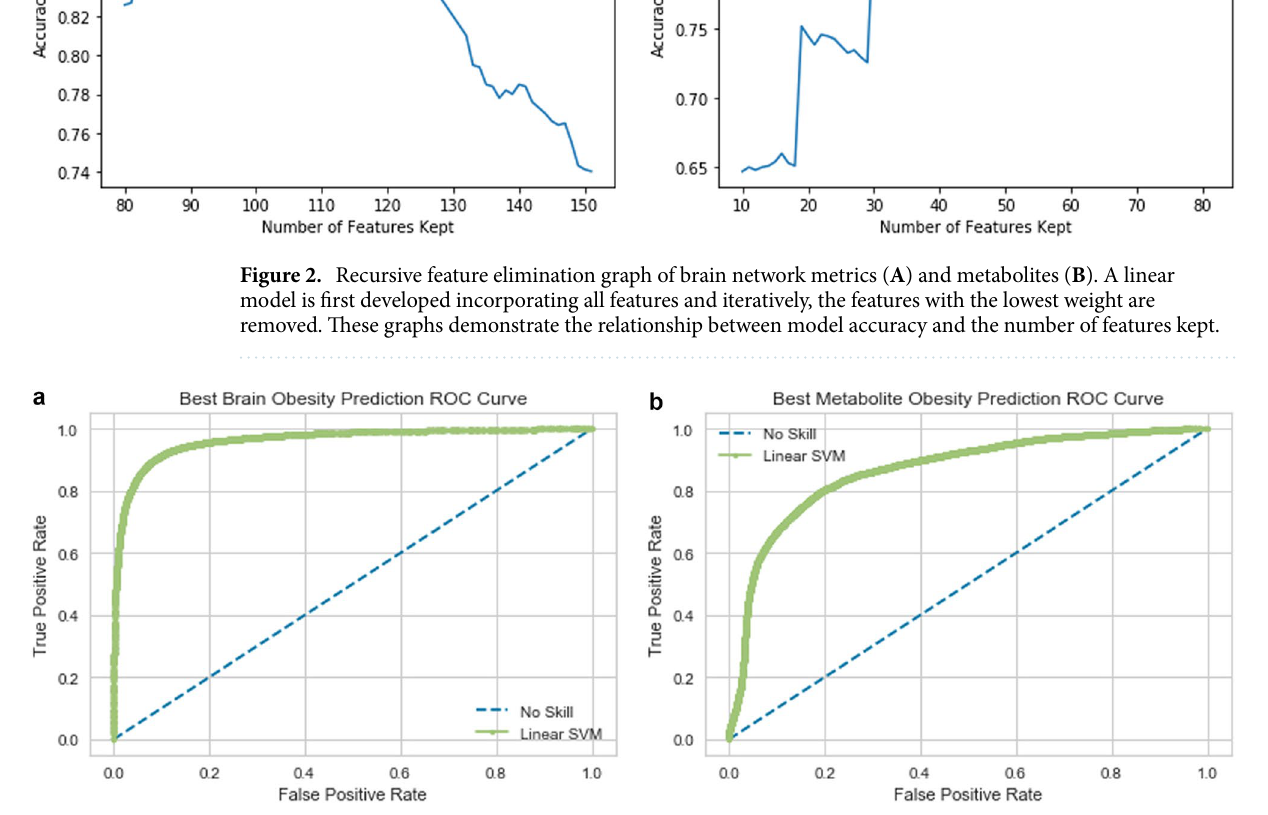
Figure 3. Receiver operating characteristic curve of support-vector machine model using brain features ( A ) exclusively, metabolite features exclusively ( B